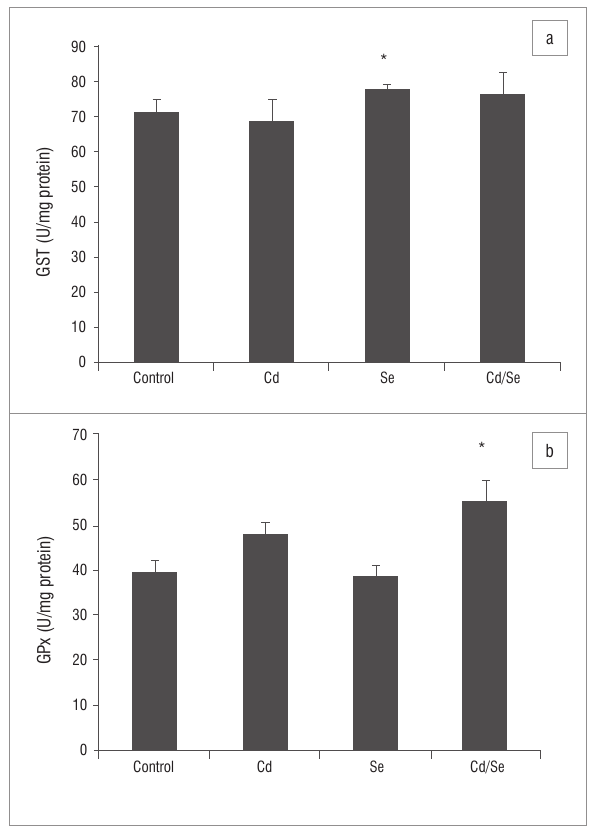
Figure 2: Mean±SD (a) glutathione s-transferase (GST) and (b) glutathione peroxidase (GPx) activities in the livers of male rats ( n =5) that received cadmium (1.67 mg/kg cadmium chloride in saline), selenium (0.23 mg/kg sodium selenite solution), cadmium and selenium (Cd/Se; 1.67 mg/kg cadmium chloride in saline and 0.23 mg/kg sodium selenite solution) or saline (control) daily (IP) for 15 days.